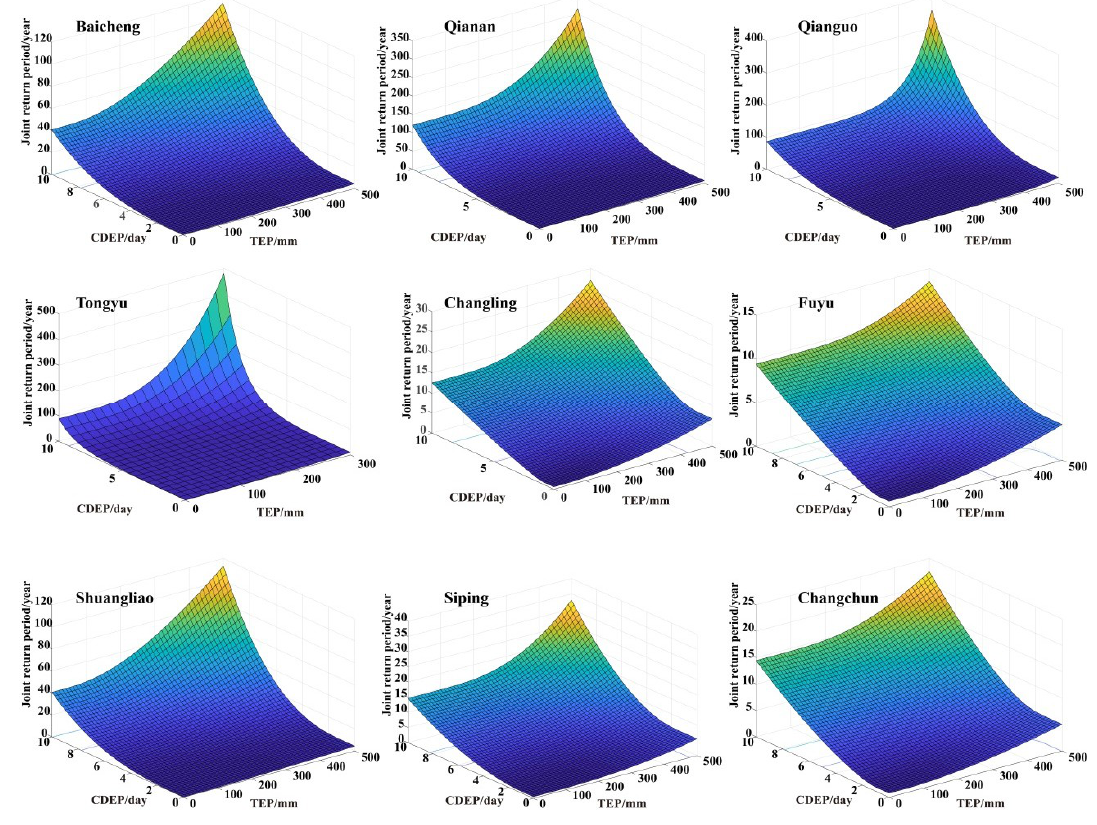
Figure 5. The joint return period of CDEP and TEP